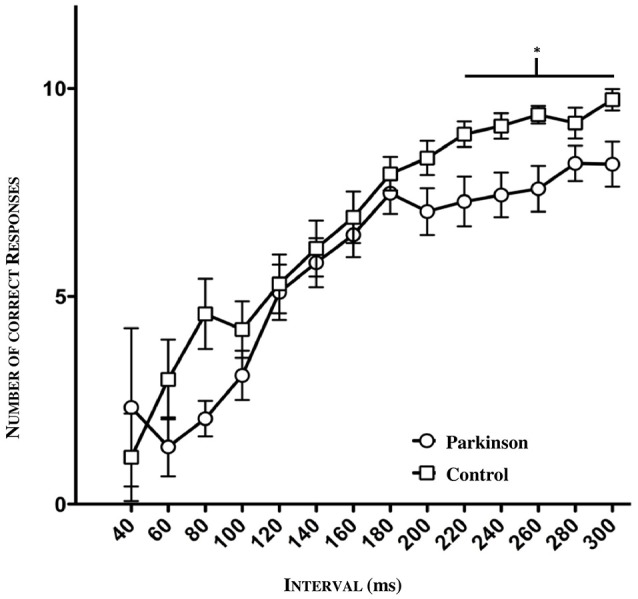
Psychometric function of patients and controls (n = 47). Significance in the higher time window between 220 ms and 300 ms (*p = 0.0200).